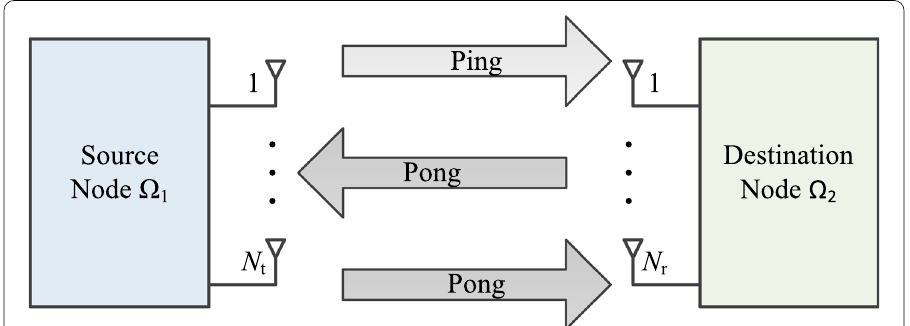
Fig. 1 Representation of the Ping – Pong – Pong scheme between source node (cid:31) 1 and destination node (cid:31)